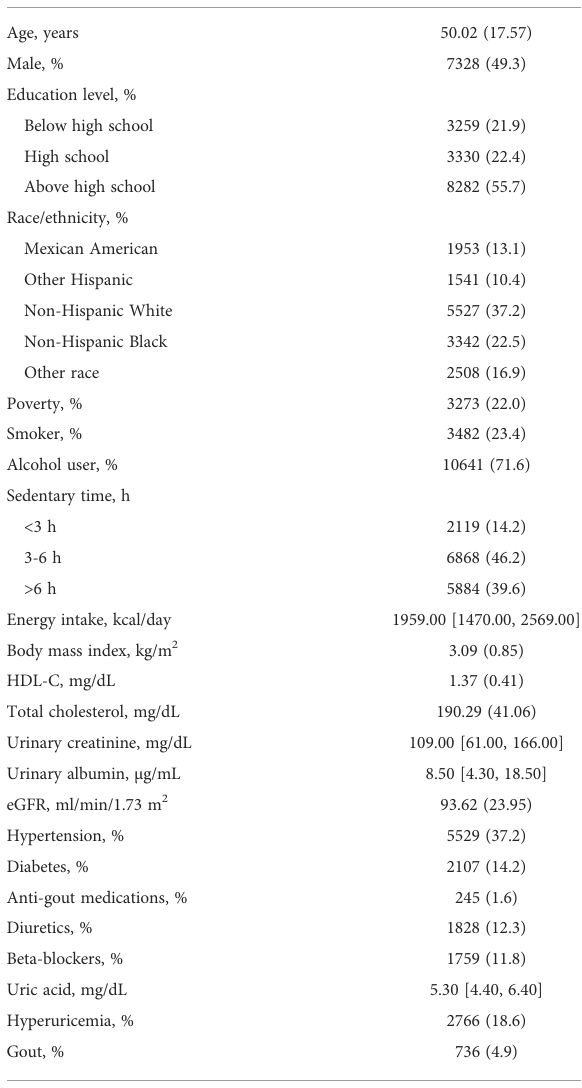
TABLE 1 Characteristics of the study